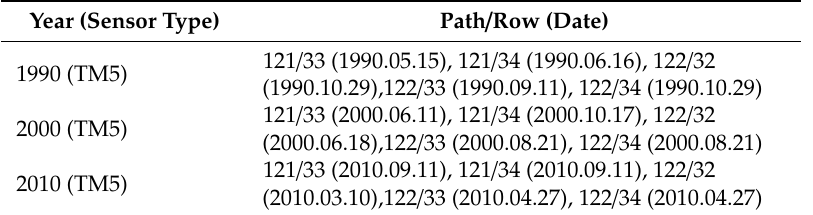
Table 1. Image data.